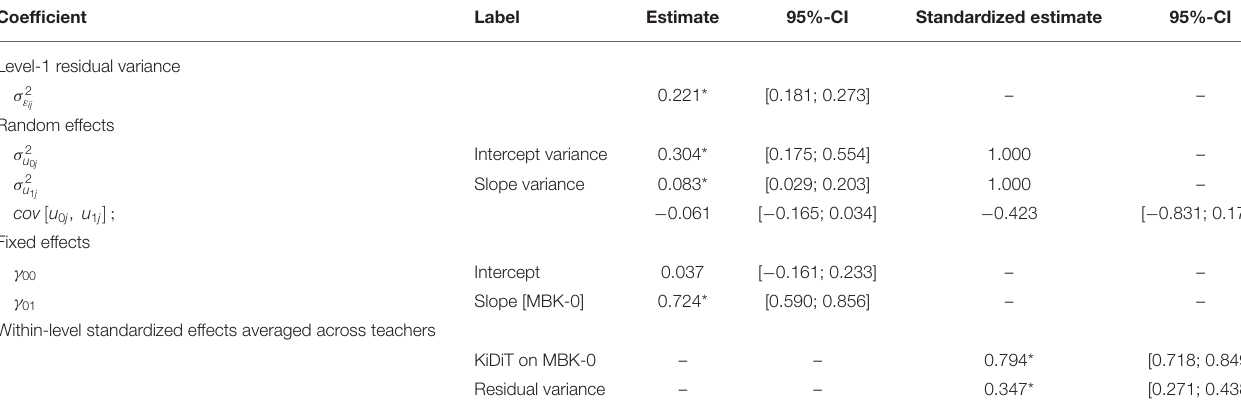
TABLE 1 | Model 1: KiDiT scores of children multilevel-regressed on MBK-0 scores of children.